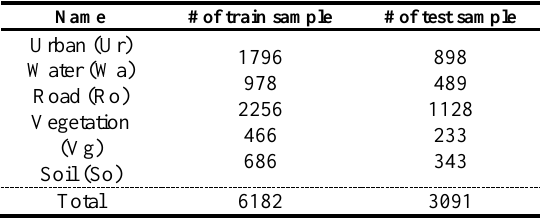
Table 3. Unsupervised threshold selection methods.